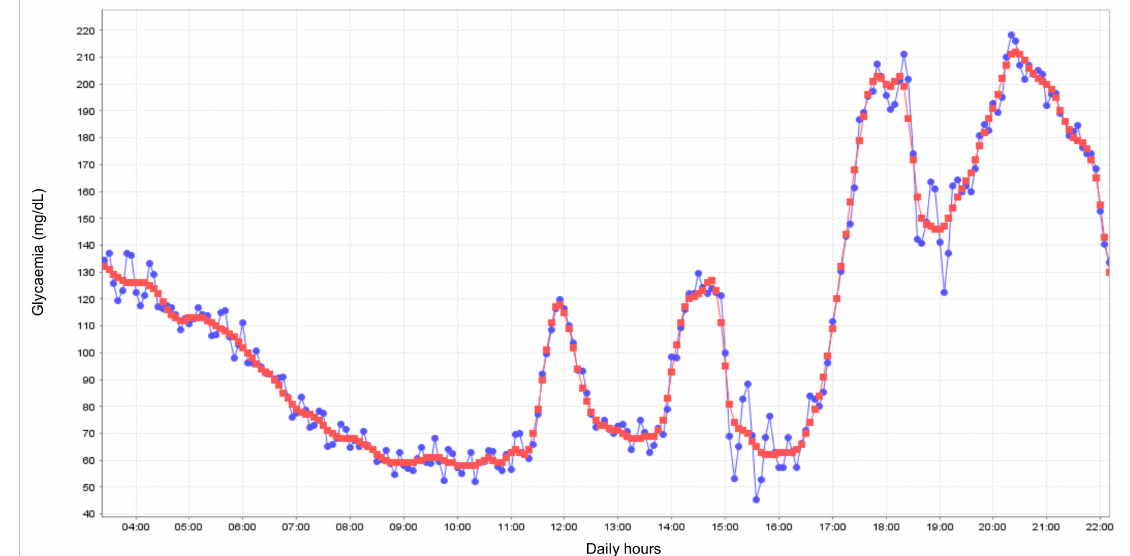
Figure 1. Example of training stage with RF algorithm of the subset RF from patient ‘01’ for a 60 min PH glycemia prediction. Red, real data of glycaemia; Blue, modeled